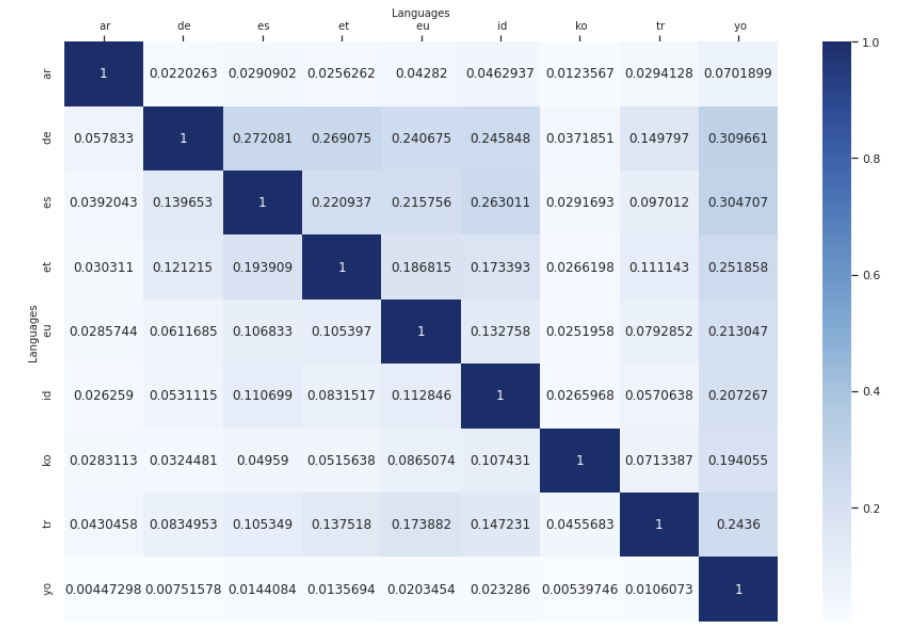
Figure 8. Coincidences between languages: degree of similarity.